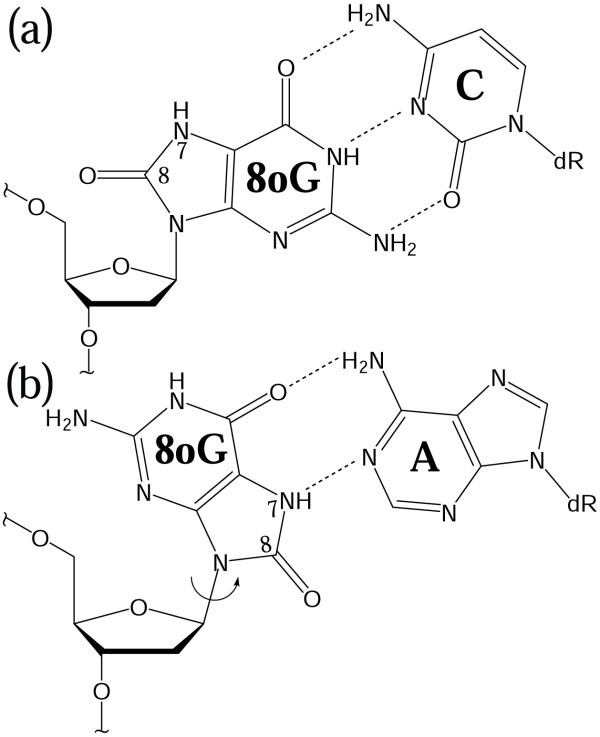
The base pairing possibilities of 8-oxoG (8oG). In an anti conformation it forms a Watson-Crick base pair with dCTP (a); by assuming a syn conformation, it can form a Hoogsteen base pair with dATP.